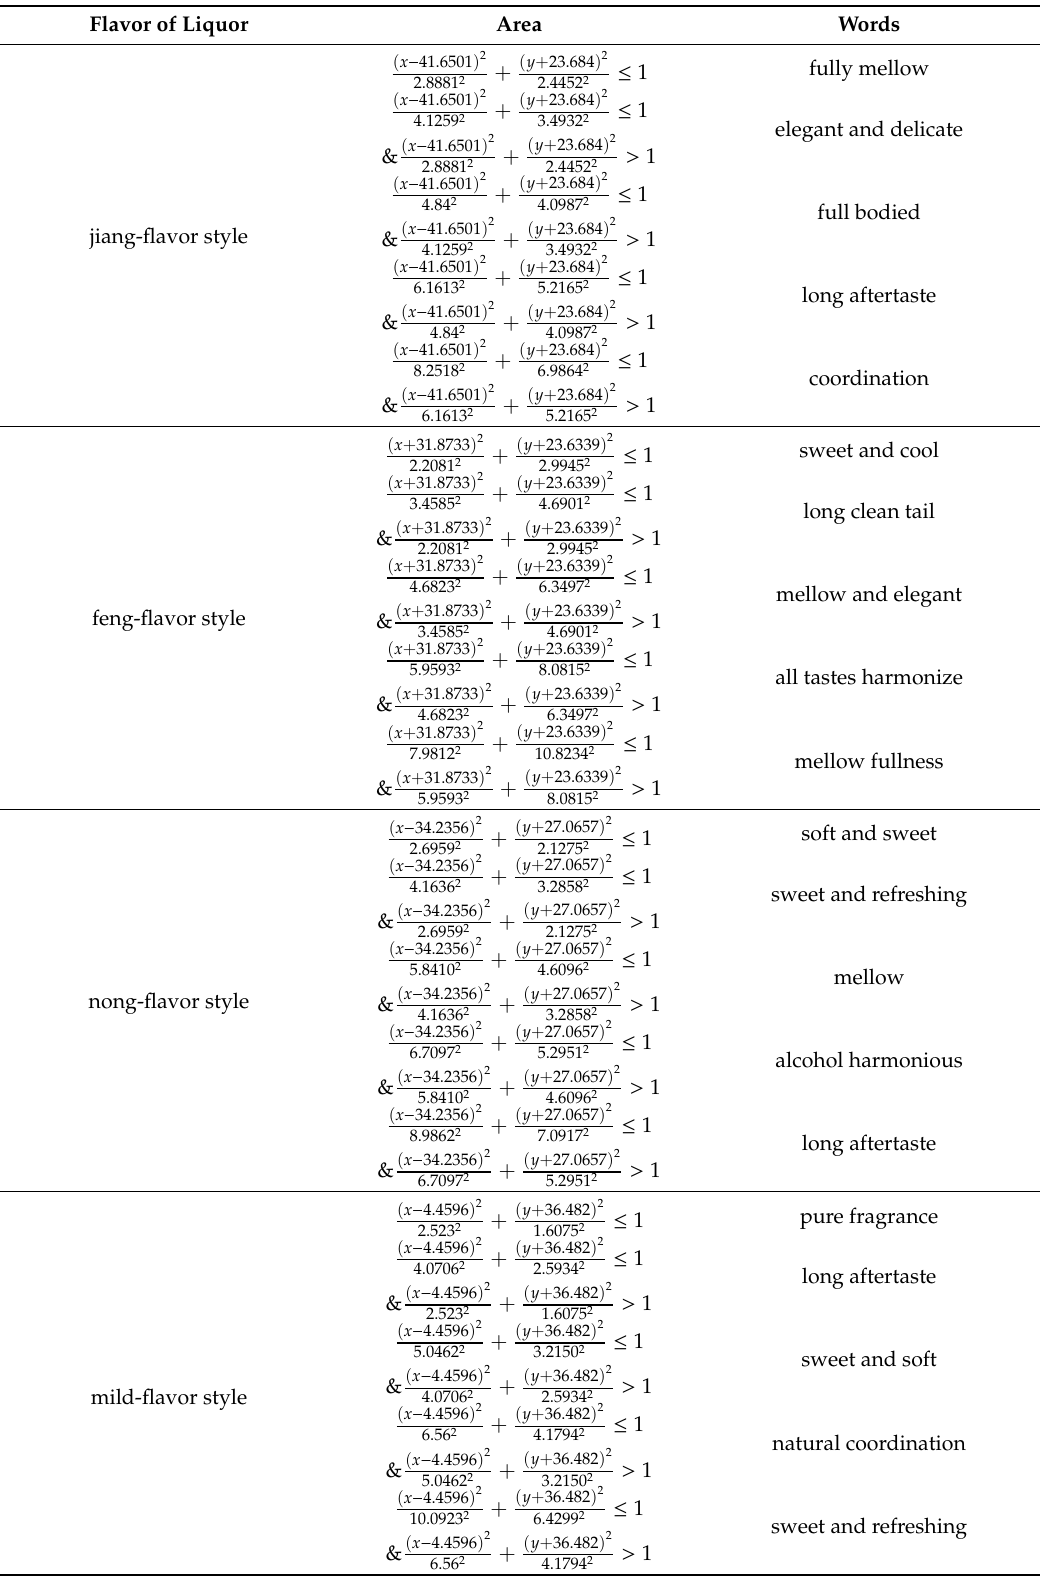
Table A1. Regional corresponding